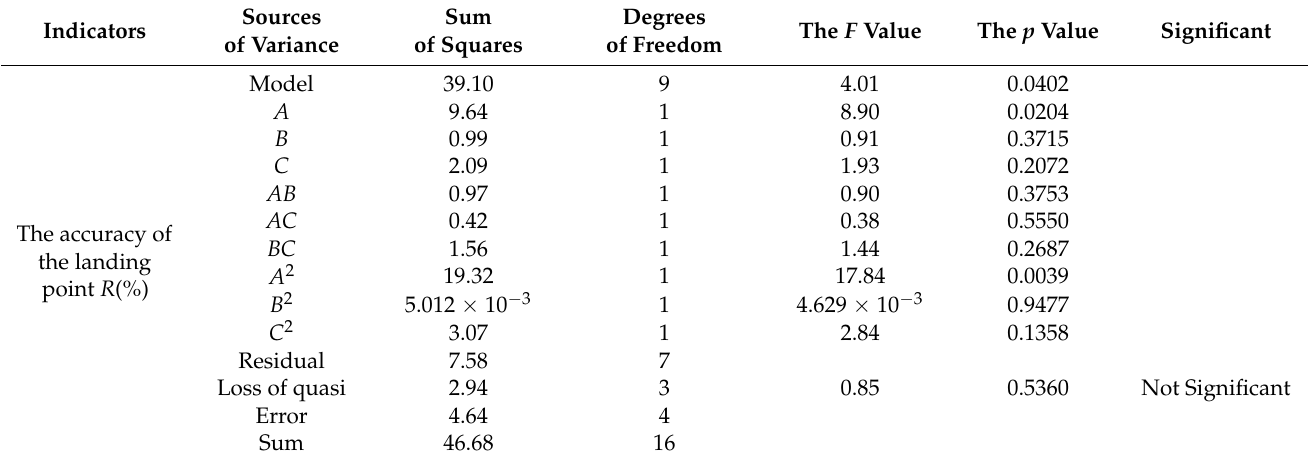
Table 3. ANOVA for regression